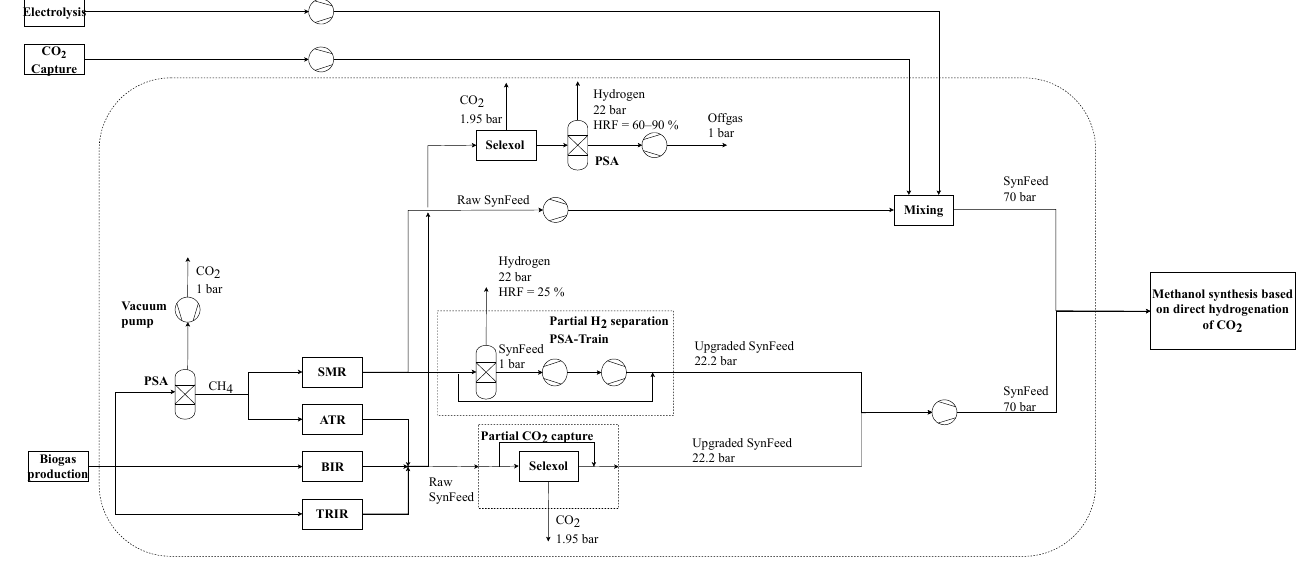
Figure 2. Biogas upgrading pathways for application in integrated biorefineries and power-to-x concepts.